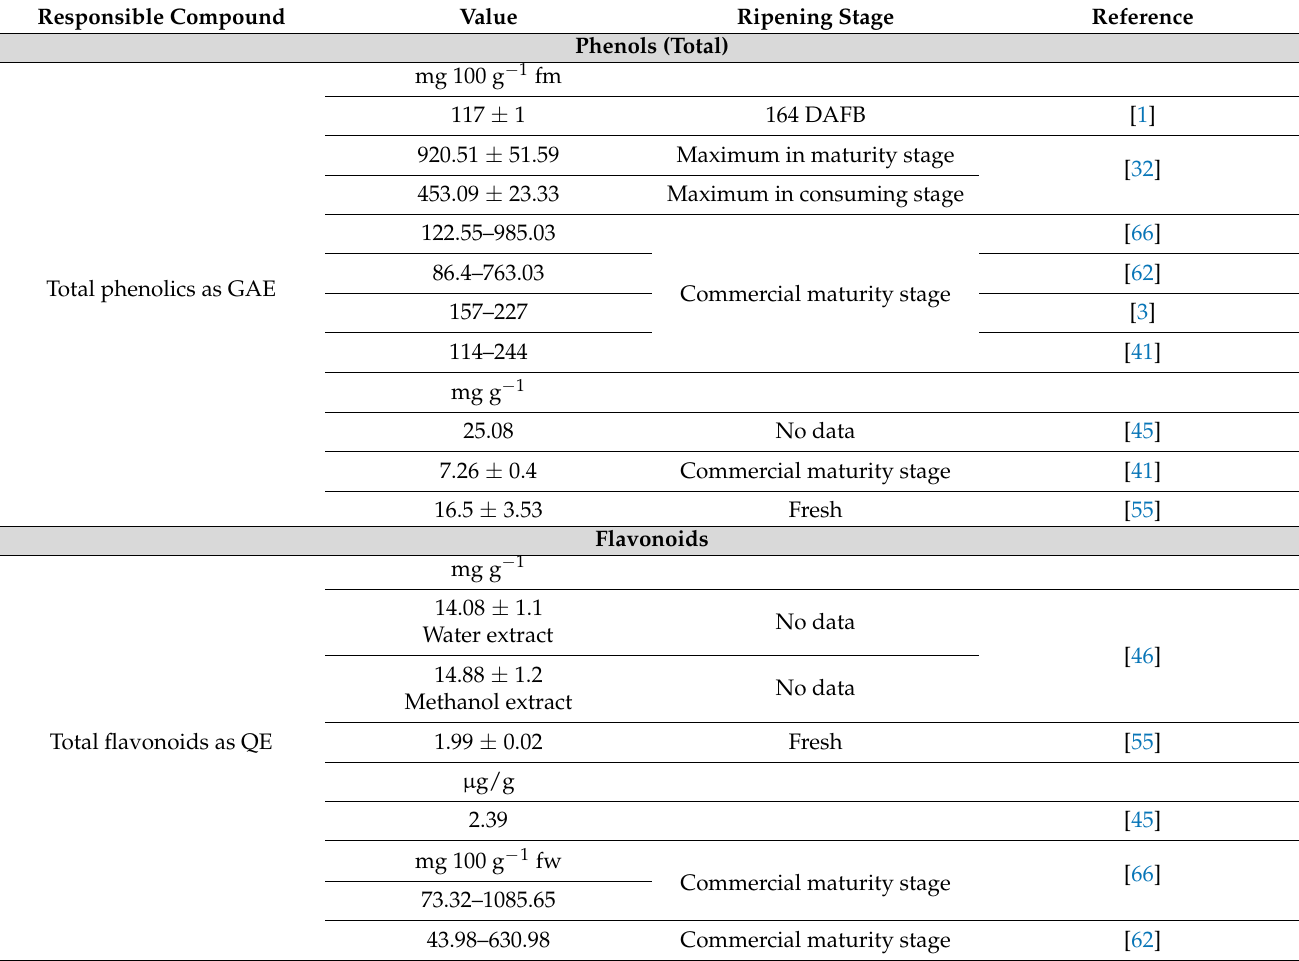
Table 9. Antioxidant compounds of Mespilus germanica L.